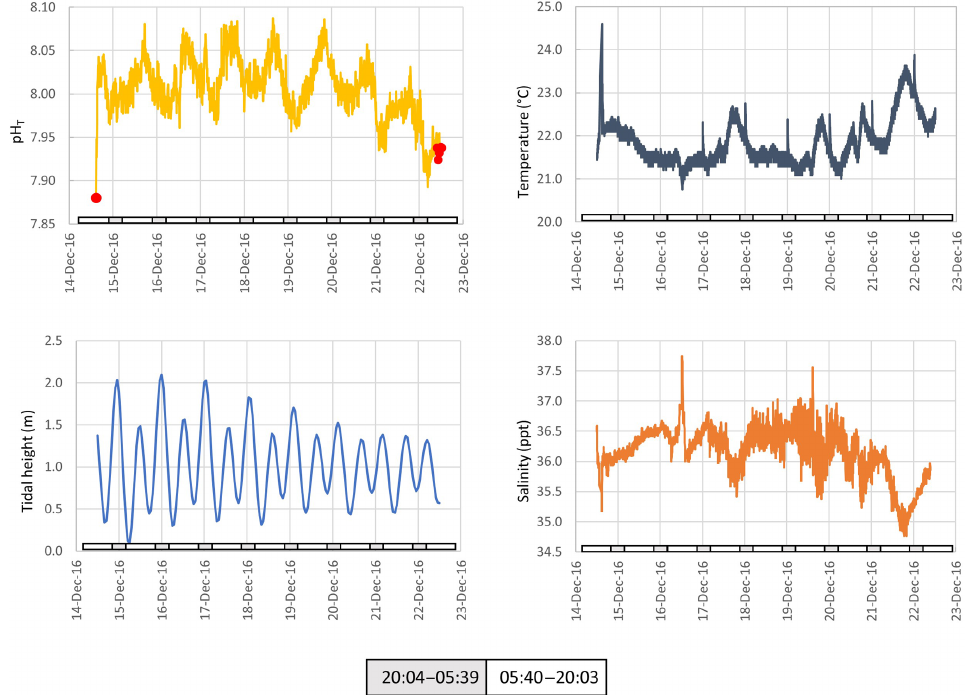
Figure 5. The pH, temperature, tidal height and salinity of seawater measured in situ at ∼ 1m below low water at Chowder Bay, Sydney over a multi-day period. Grey and white boxes indicate the time between sunset and sunrise. Red dots indicate values of reference samples collected adjacent to the device and measured using